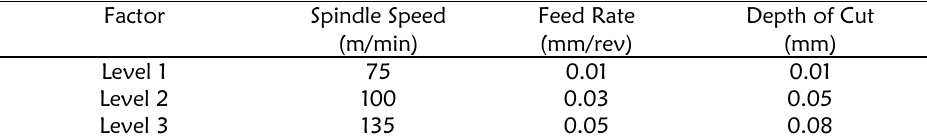
Table 2: Process and their levels for dry and cooled machining